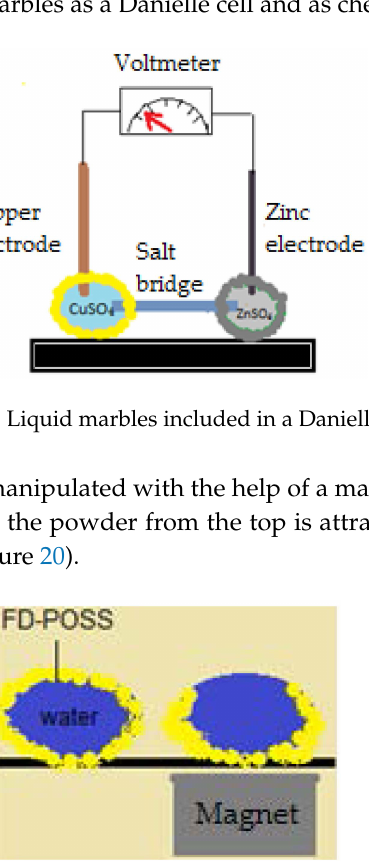
Figure 20. Liquid marble covered in FD-POSS. Migration of the powder towards the bottom, due to a magnetic